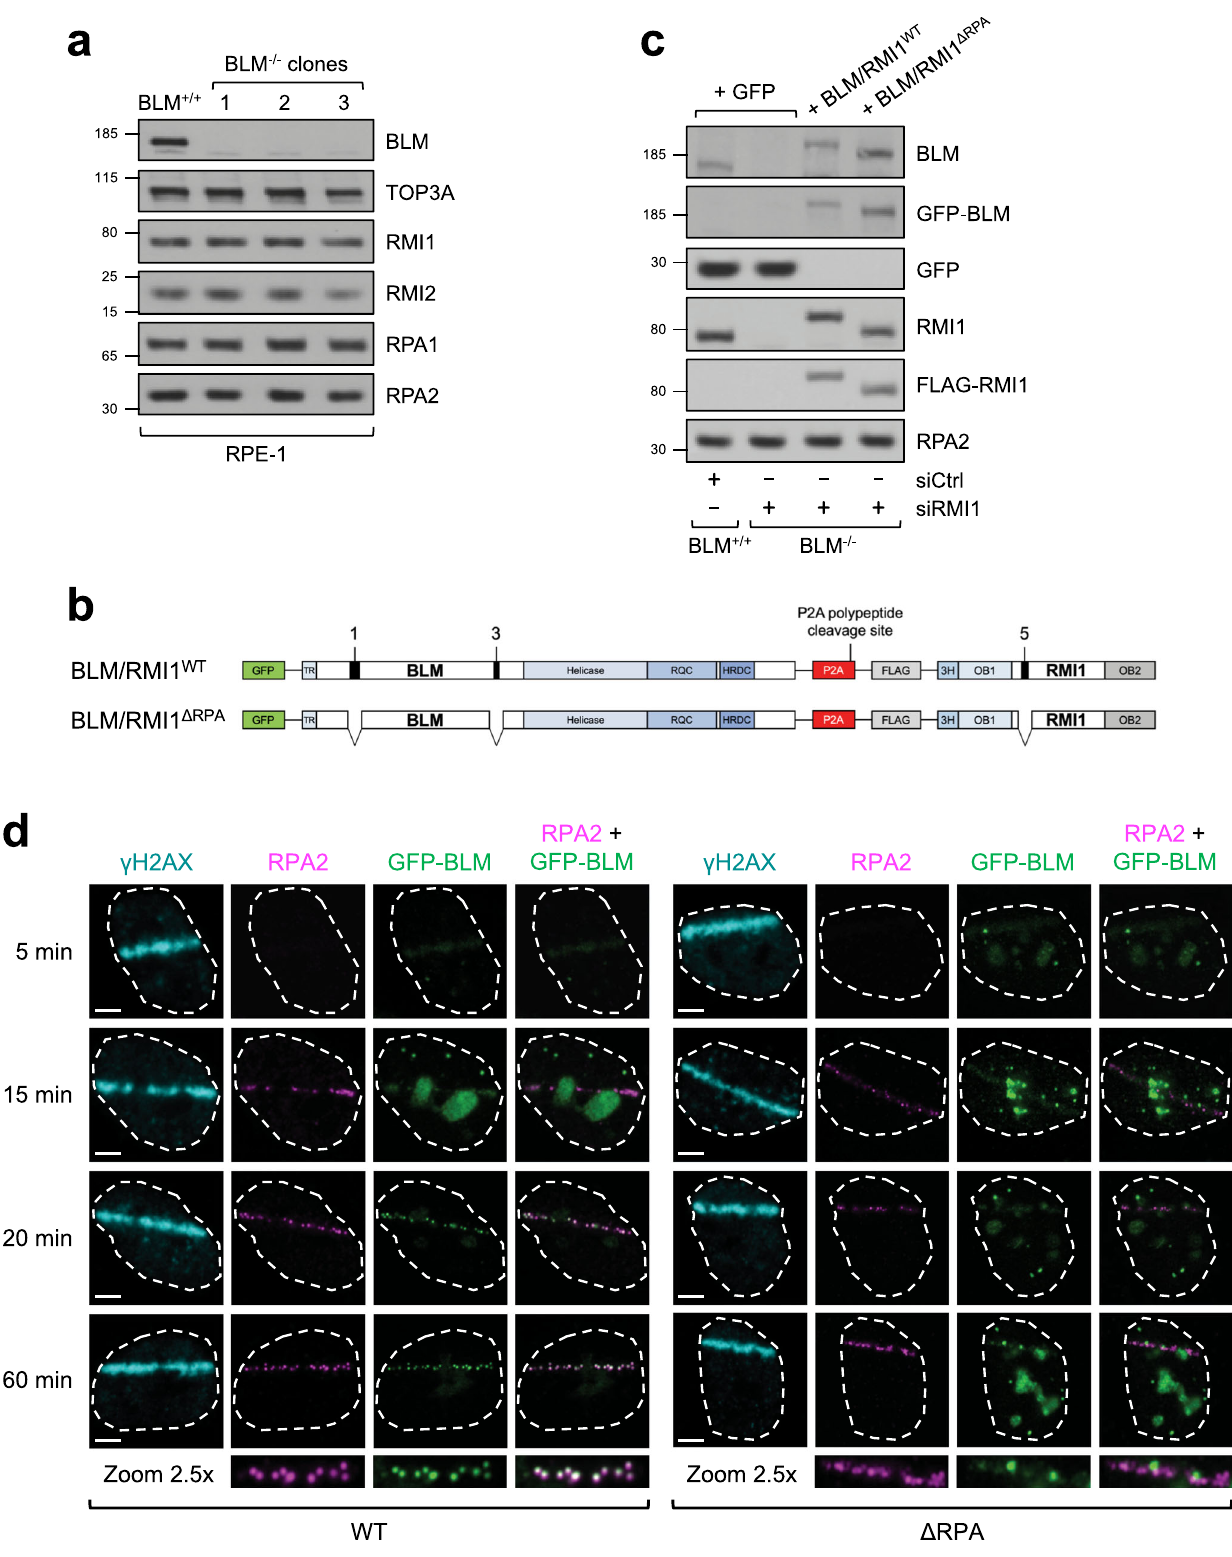
Fig. 3 Generation and complementation of BLM − / − RPE-1 cells with RPA-binding mutants of BLM and RMI1. a Western blots showing that BLM expression is undetectable in three separate BLM knockout RPE-1 clones. b Schematic showing the complementation strategy for adding back WT BLM/ RMI1 proteins or mutant ones lacking RPA-binding motifs to BLM − / − cells treated with siRMI1. c Western blots showing the levels of exogenous GFP and BLM/RMI1 proteins delivered by lentivirus in WT or BLM − / − cells treated with siCtrl or siRMI1 as indicated. d Airyscan high-resolution confocal microscopy image time-course, showing the kinetics of recruitment of γ H2AX, RPA2, and WT/mutant GFP-BLM proteins to laser-induced DSBs in representative cells. Zoomed-in images of laser lines are from the 60-min time-point images. Scale bars, 5 μ